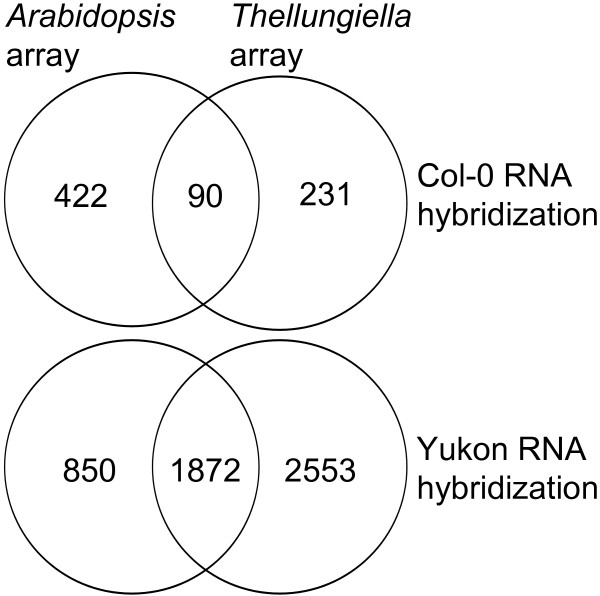
Comparison of significant gene expression changes determined using the Agilent Arabidopsis or Thellungiella salsuginea arrays. Venn diagrams show the overlap between genes with significant (linear model, FDR, p < 0.05) changes in expression detected using data from the Arabidopsis or T. salsuginea arrays hybridized with either Col-0 or Yukon RNA. To ensure valid comparisons, all T. salsuginea genes were matched with Arabidopsis genes using BLASTX.